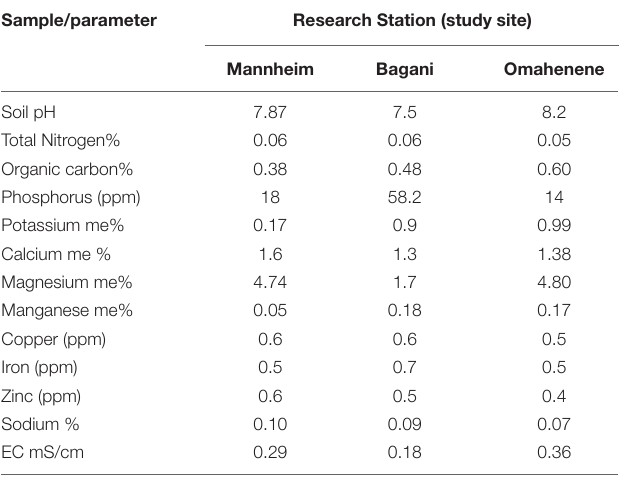
TABLE 1 | Physicochemical properties of soils at Mannheim, Bagani, and Omahenene research sites in Namibia.